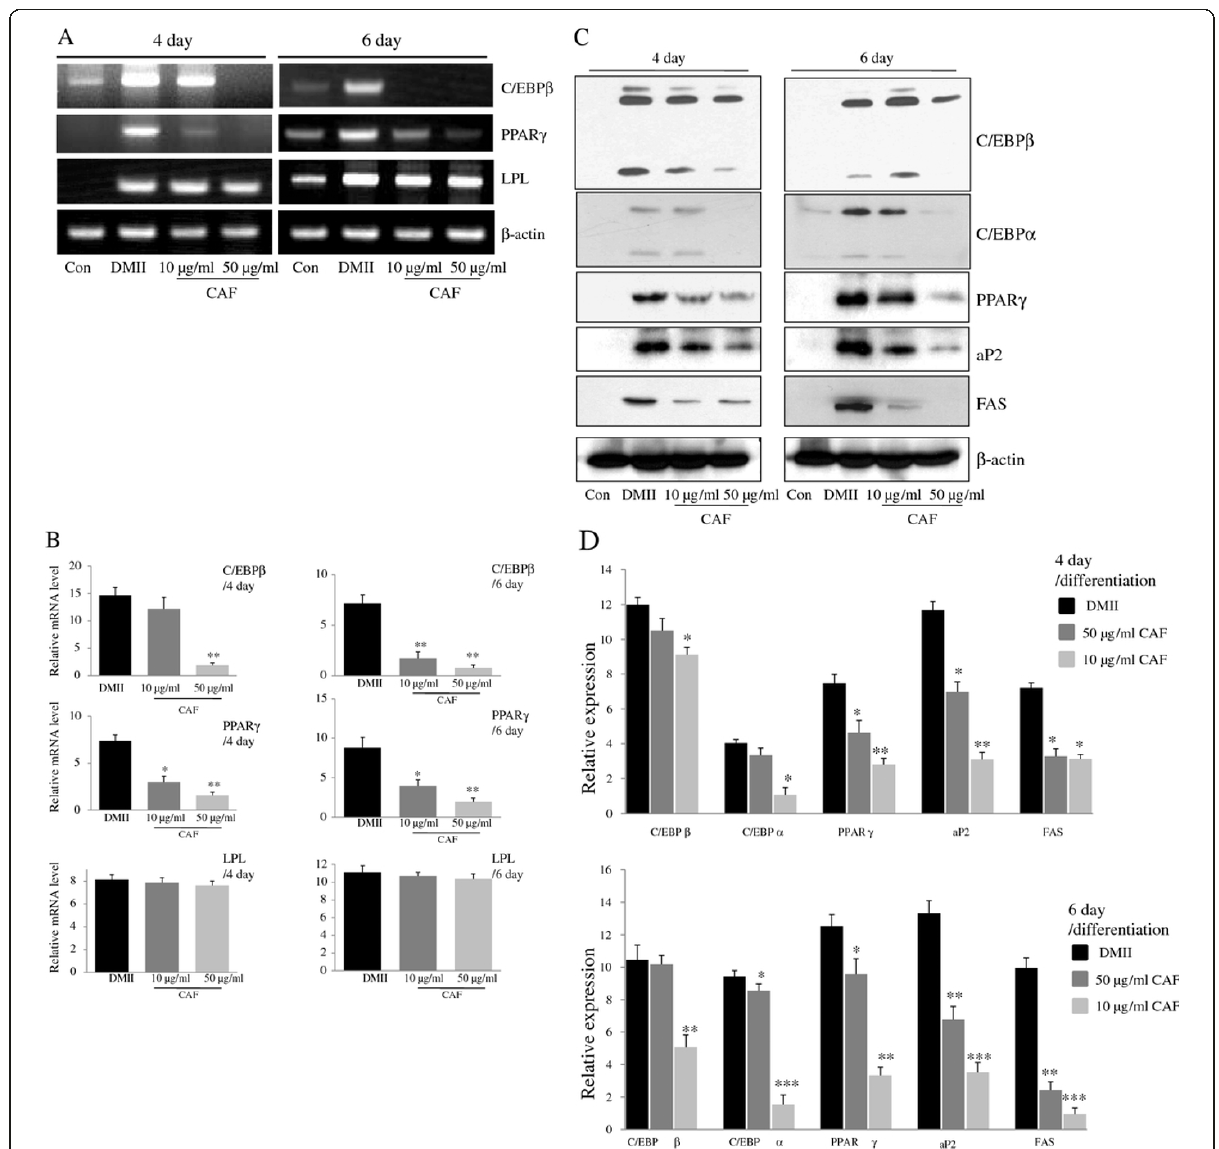
Figure 2 Effect of CAF on the expression of adipogenesis-related genes in 3T3-L1 adipocytes . 3T3-L1 cells were differentiated in the absence or presence of CAF for 4 or 6 days. (A) CAF inhibited the expression of adipocyte-specific transcription factors, C/EBP b and PPAR g mRNA during adipocyte differentiation. The differentiation of 3T3-L1 preadipocytes was induced by DMII medium in the absence or presence of 10 and 50 μ g/ml CAF. Total RNA was isolated from 3T3-L1 adipocytes at day 4 and day 6 after induction of differentiation. The expression of C/ EBP b and PPAR g was examined by RT-PCR. (B) The relative expression of adipocyte-specific genes after treating CAF for 4 or 6 days. All gene expressions were normalized using b -actin as a reference gene. The data shown are representative of three independent experiments. (*) p < 0.05, (**) P < 0.01 versus the control (DMII) group at each gene expression. (C) CAF inhibited the expression of adipogenesis-related genes in 3T3-L1 adipocytes. Total cell lysates were isolated from 3T3-L1 adipocytes at day 4 and day 6 after induction of differentiation. Immunoblotting analysis was performed as described in Materials and Methods. (D) The relative expression of adipogenesis-related genes after treating CAF for 4 or 6 days. The data shown are representative of three independent experiments. (*) p < 0.05, (**) P < 0.01, (***) P < 0.001 versus the control (DMII) group at each gene